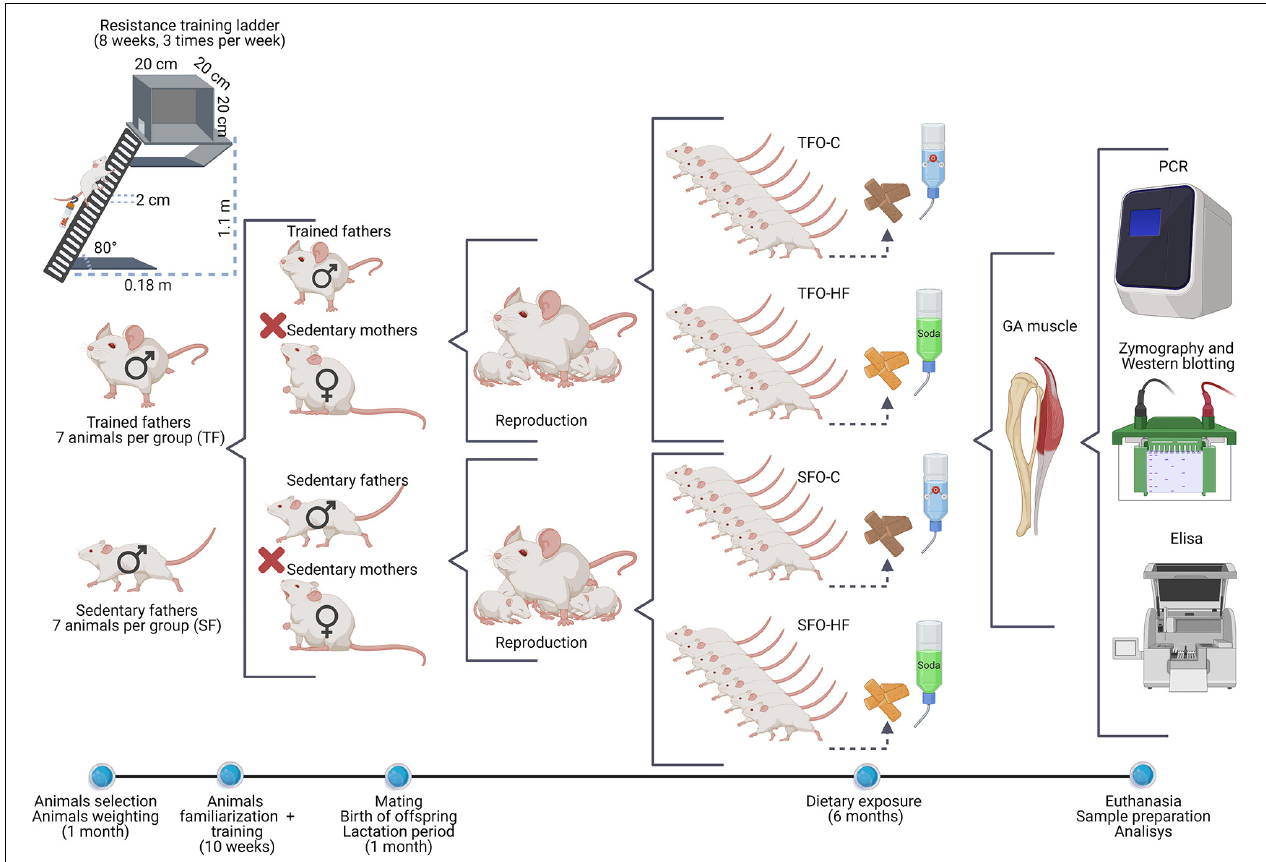
FIGURE 1 | Schematic representation of the experimental design. Illustration of the methodological sequence followed in the intergenerational study.